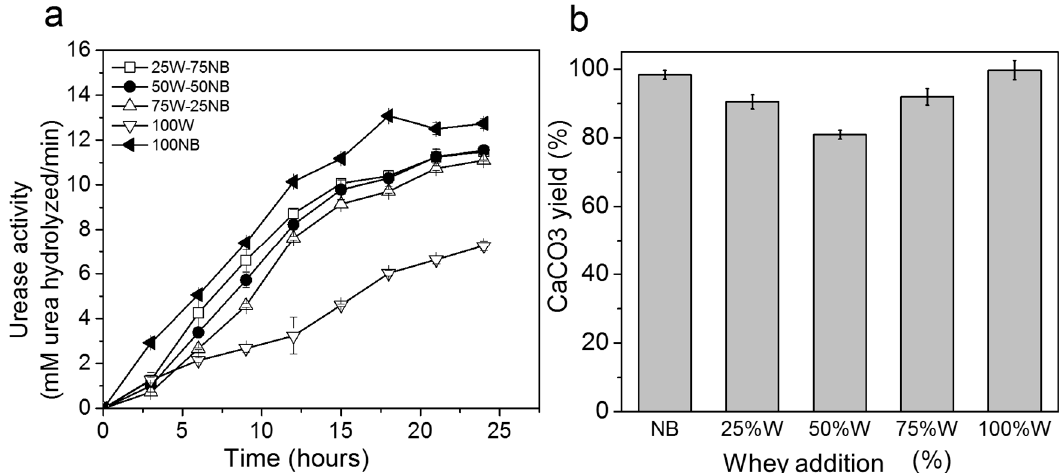
Figure 2. Effect of whey at different proportions in nutrient broth on ( a ) urease activity, and ( b ) CaCO 3 yield.